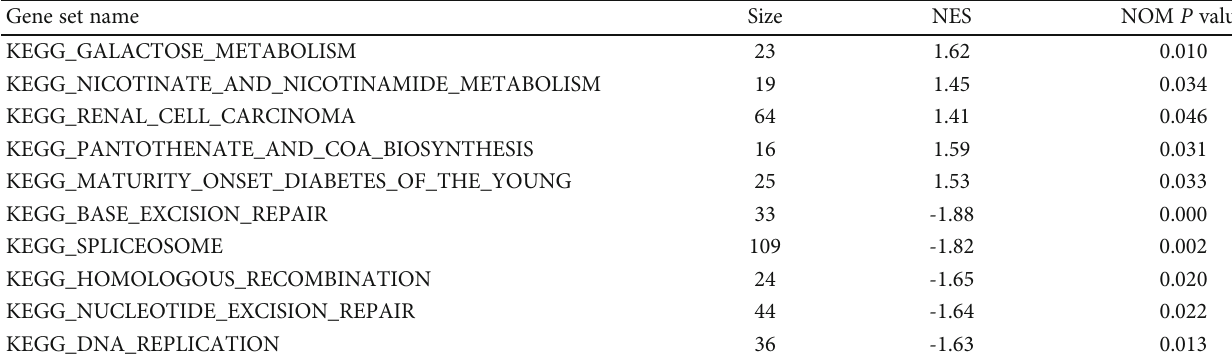
Figure 6: Then samples were divided into high- and low-risk groups as training set to distinguish the potential function and elucidate the signi fi cant survival di ff erence utilizing GSEA. Table 3: Gene sets enriched in phenotype high and